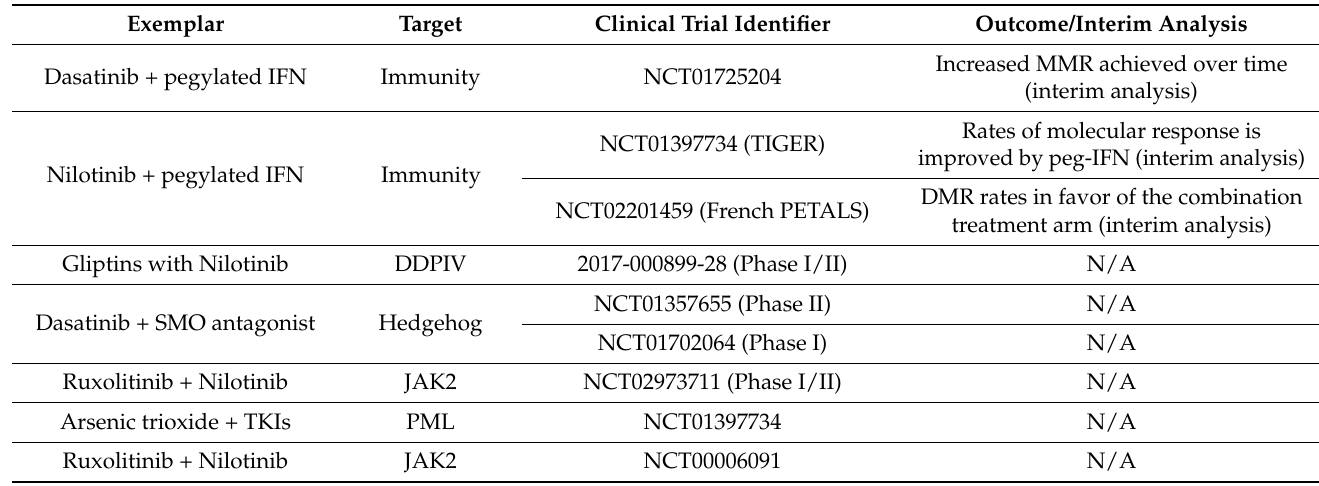
Table 2. Candidate targets and clinical trials for CML